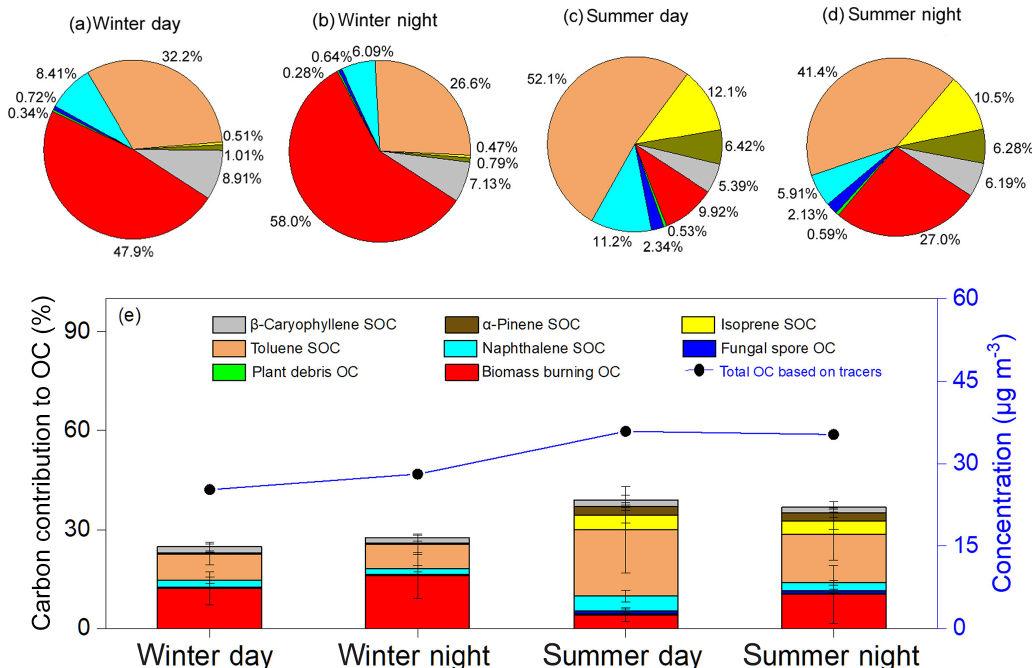
Figure 14. (a–d) Relative contributions of primary and secondary OC (corresponding to day- and night-time in winter and summer re- spectively) and (e) accumulative primary and secondary OC and its contribution to OC in fine particles (%) in Tianjin during winter and